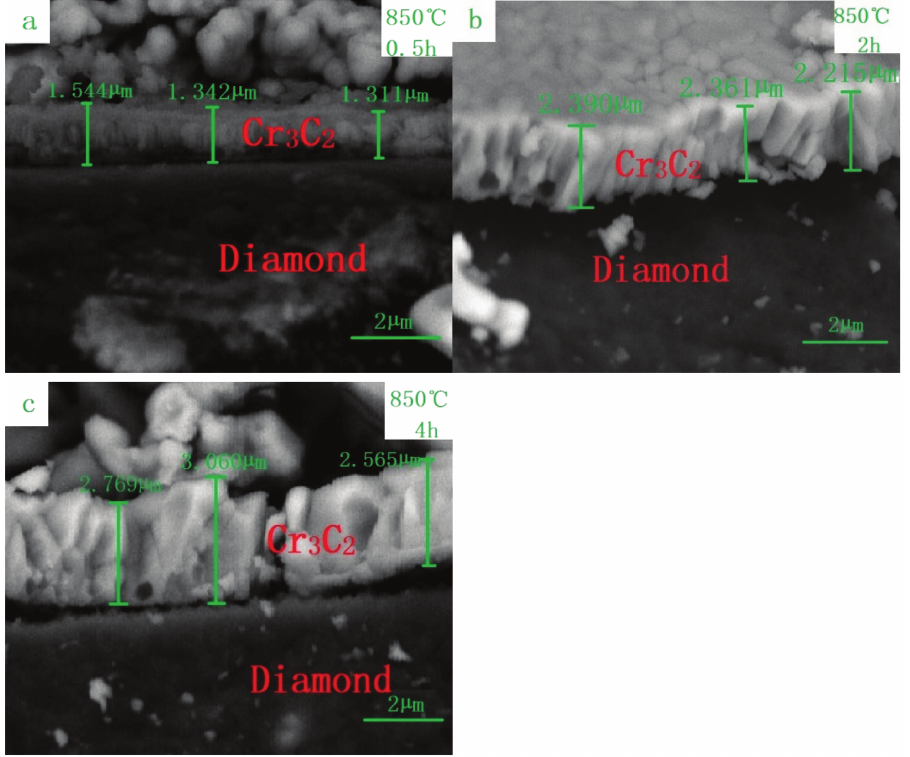
Figure 9: The coating thickness of SEM images by microwave heating at temperature of 850 ° C for different time (a) 0.5 h, (b) 2 h and (c) 4 h.